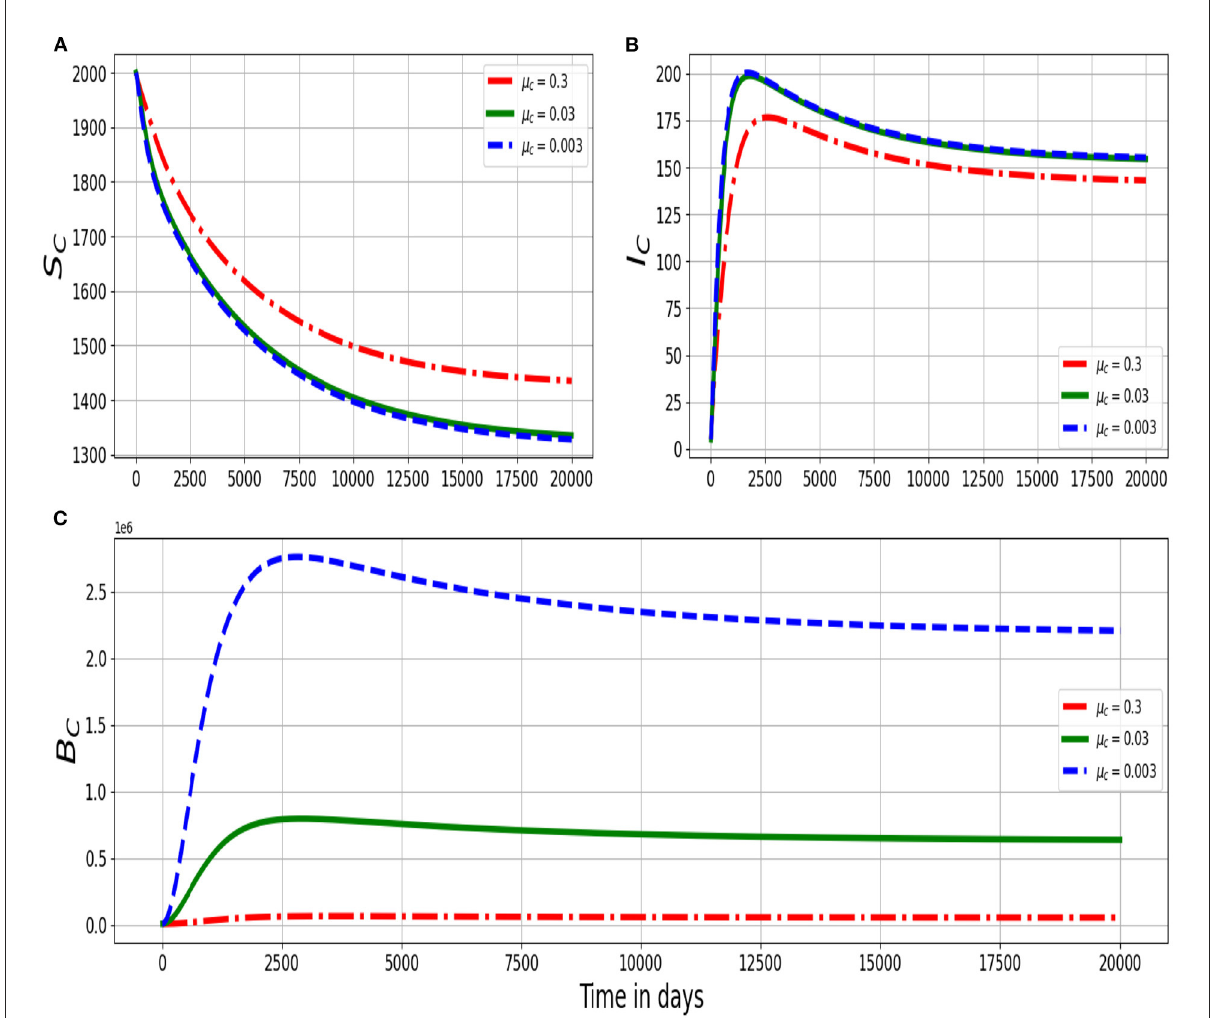
FIGURE4 Graphs of numerical solutions of the multiscale model system(2.4) showing changes in (A) population of susceptible ruminants ( S C ), (B) population of infected ruminants ( I C ), and (C) population of environmental MAP bacterial load ( B C ) for different values of death rate of the within-host MAP bacterial load µ c : µ c = 0.3, µ c = 0.03, and µ c =